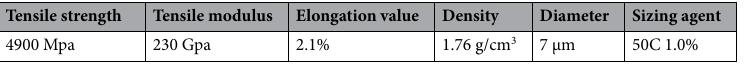
Table 1. Main parameters of carbon fiber.